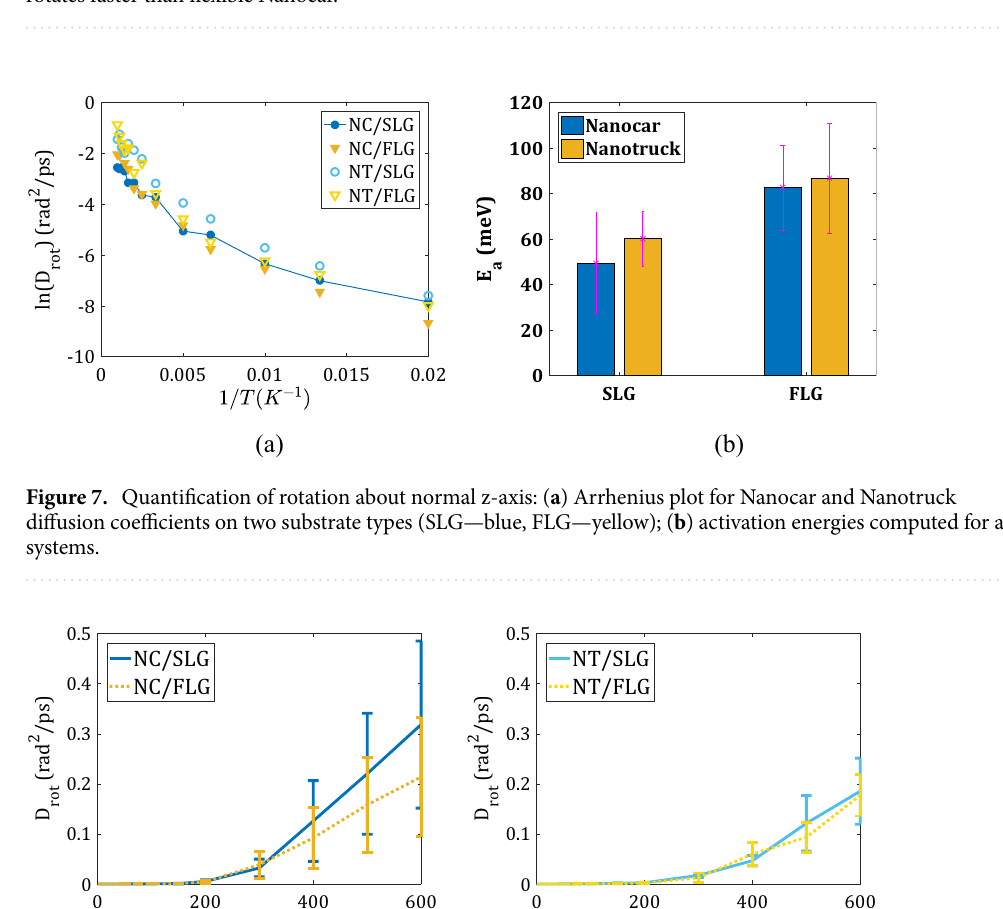
Figure 6. Rotational diffusion coefficient around the vertical axis as a function of temperature. Nanotruck rotates faster than flexible Nanocar.